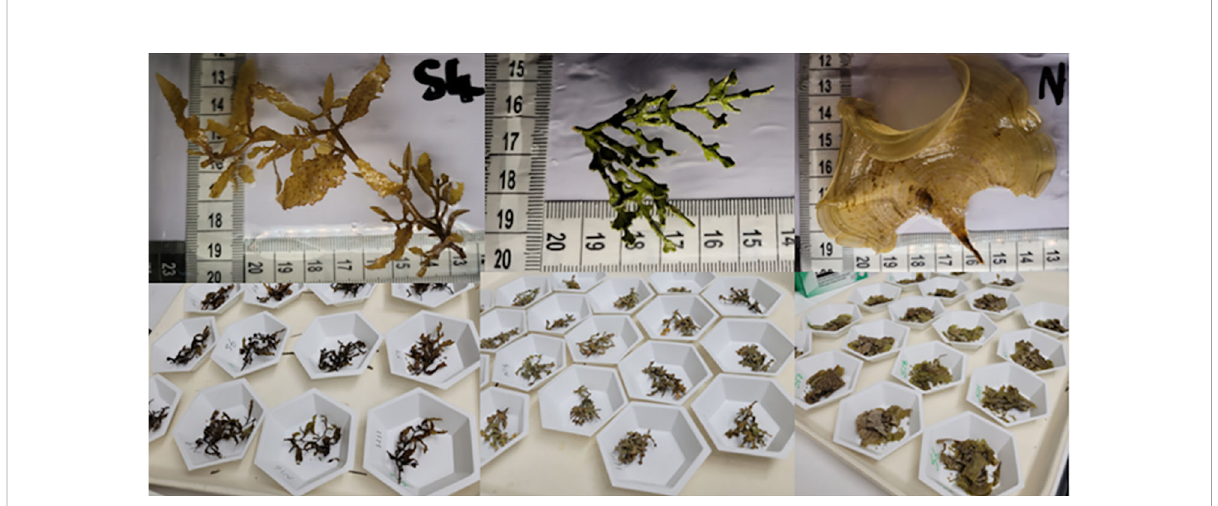
FIGURE 1 Upper panel (left to right): experimental samples, fragments of Sargassum latifolium , Halimeda opuntia , and Padina boryana . Lower panel: oven- dried samples after the